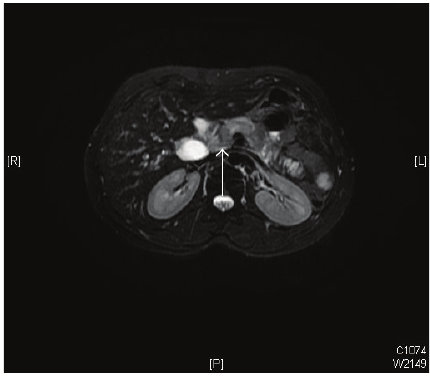
Figure2:MagneticResonanceCholangiopancreatography(MRCP) showing a small hypovascular 1.8 × 1.5 cm mass in the pancreatic neck, invading the superior mesenteric